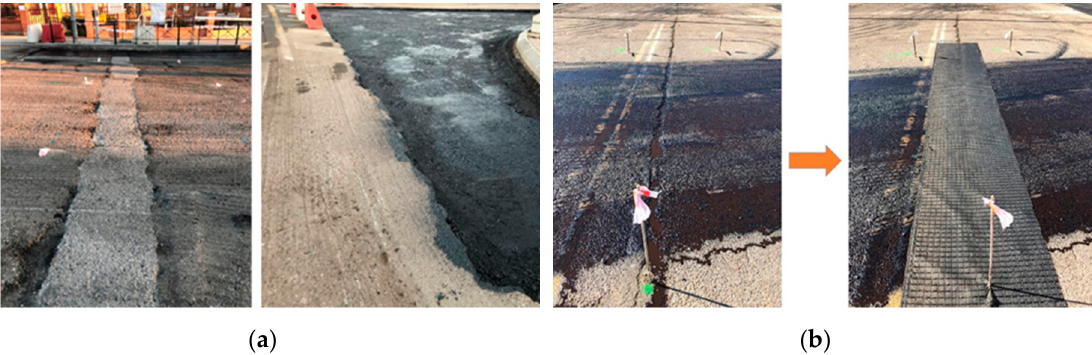
Figure 2. ( a ) Discontinuities in urban roads; ( b ) Incorrect performance over a longitudinal